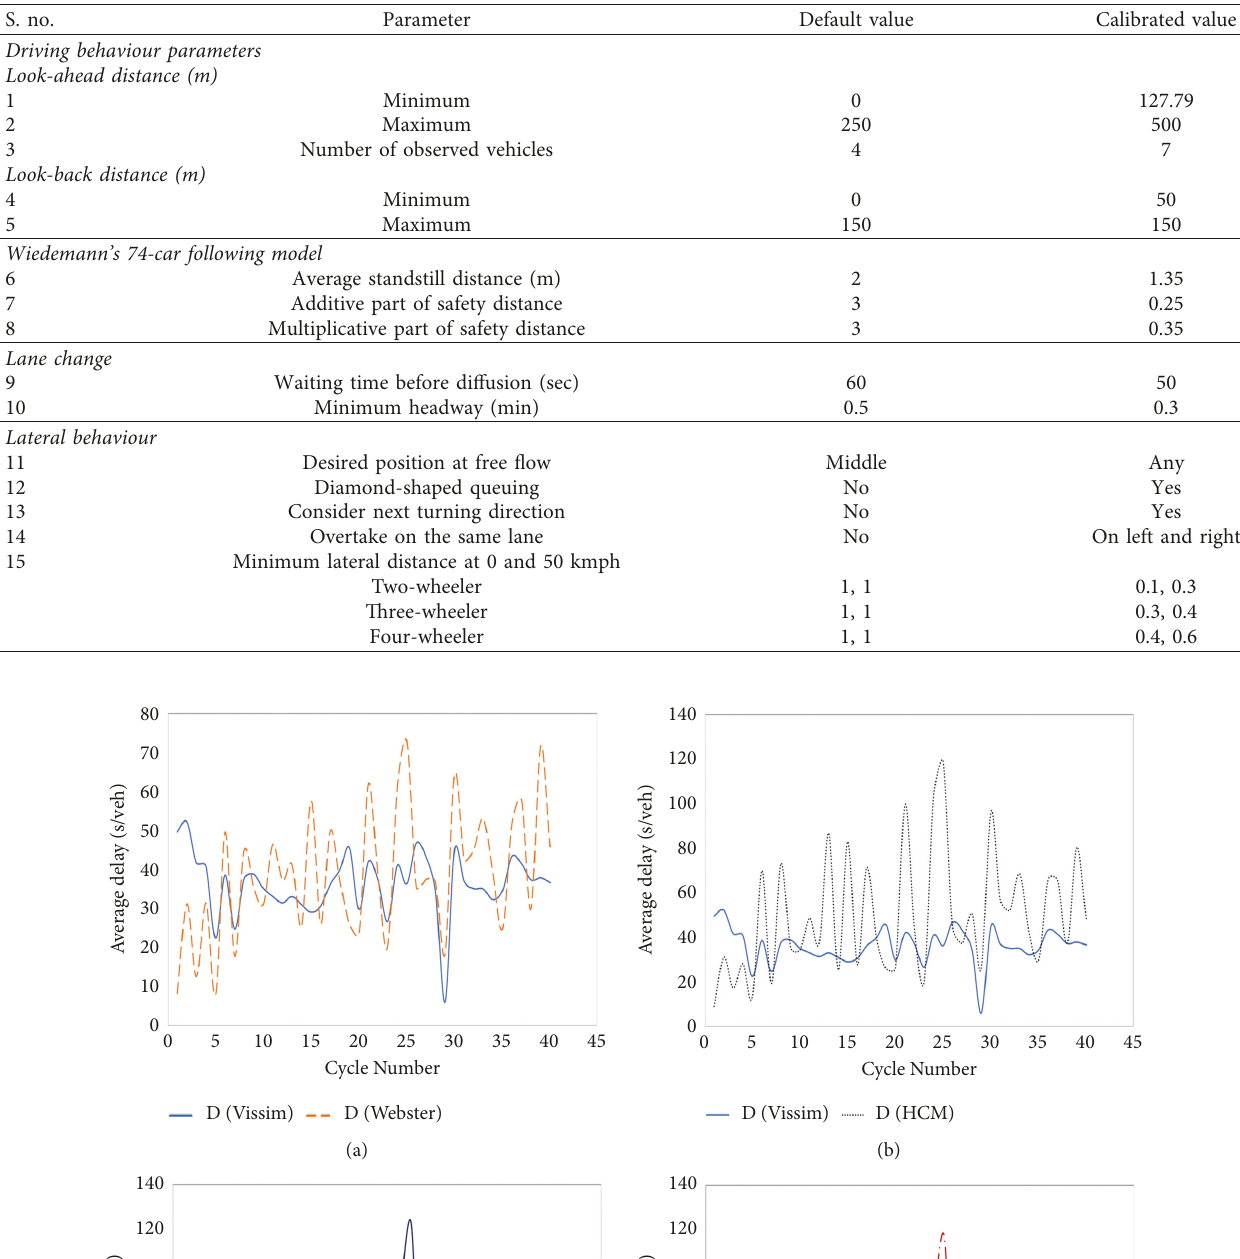
Table 3: Summary of the calibration parameters used from literature